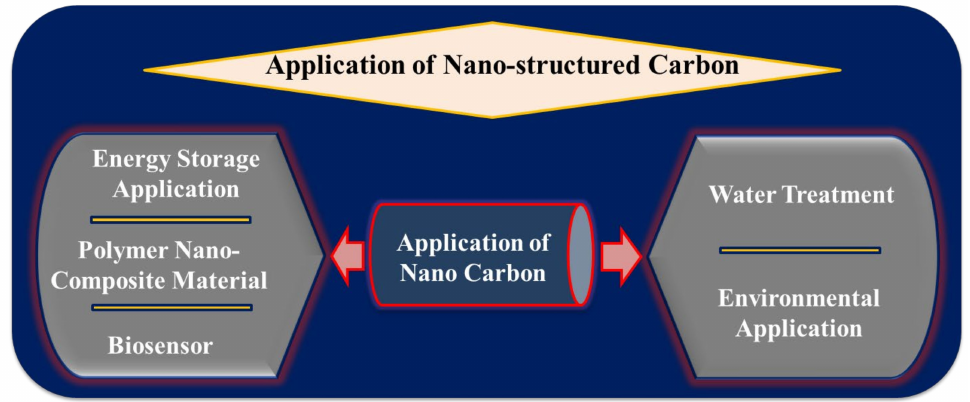
Figure 16. Pictorial description of nano-structured carbon applications in different